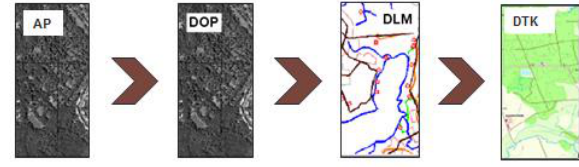
Figure 1. Traditional workflow for aerial survey results in NMCAs